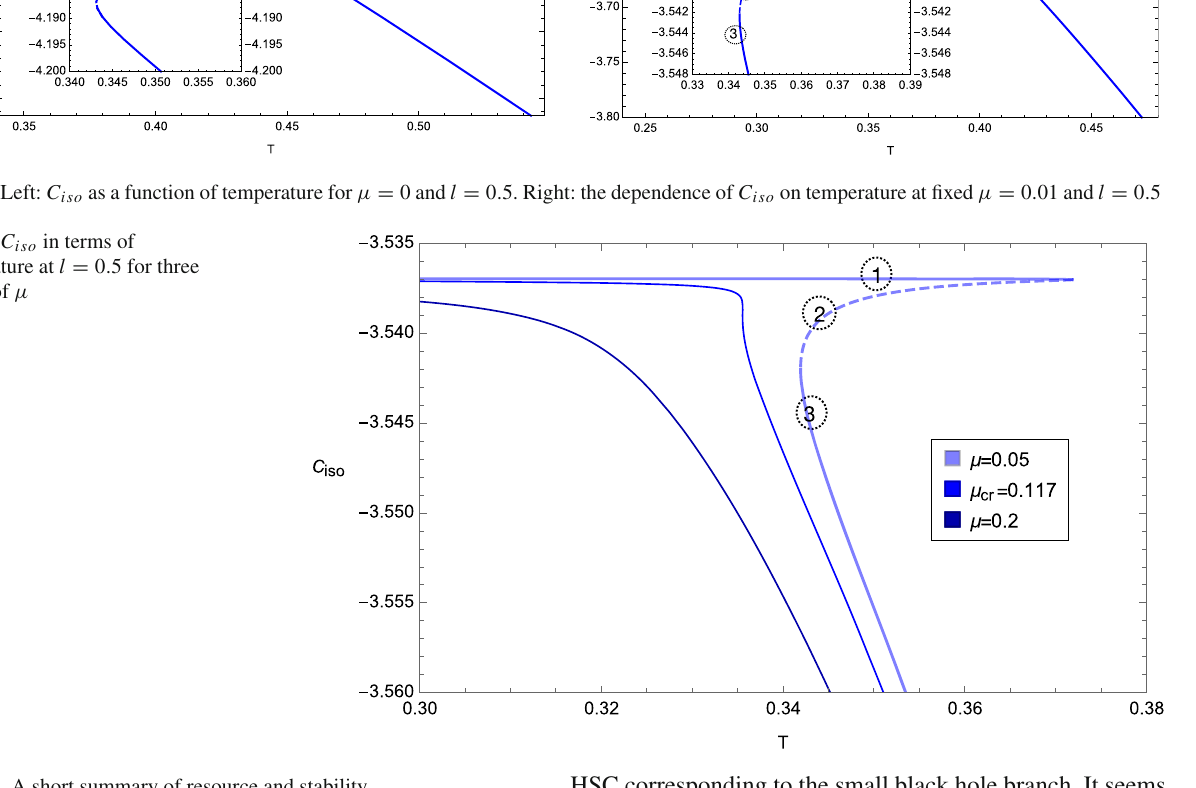
Table 1 A short summary of resource and stability